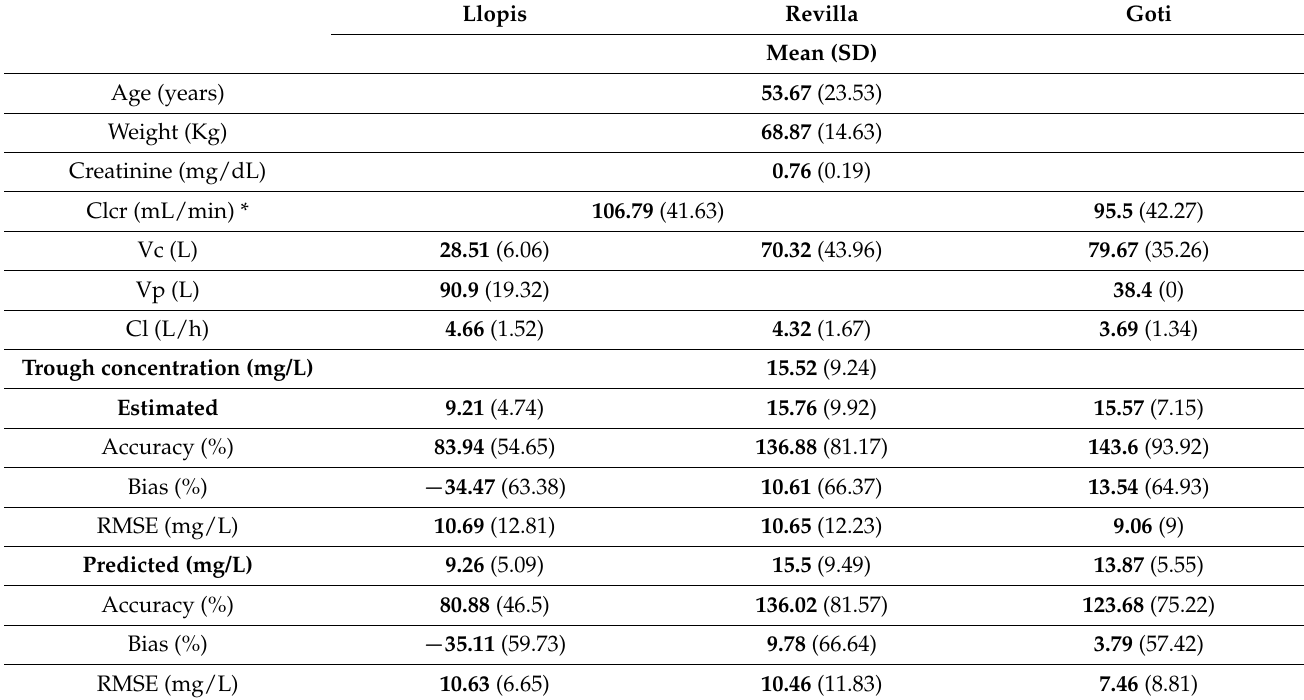
Table 1. Comparative results of PopPk.